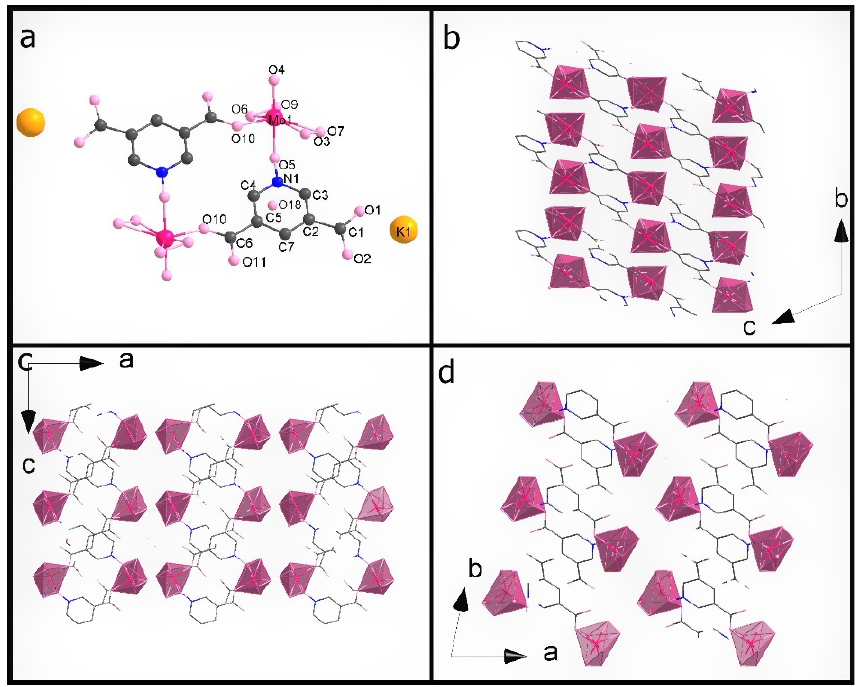
Figure 2. ( a ) The asymmetric unit of K35dcpa ; packing diagram of K35dcpa along ( b ) a axis , ( c ) b axis, and ( d ) c axis.